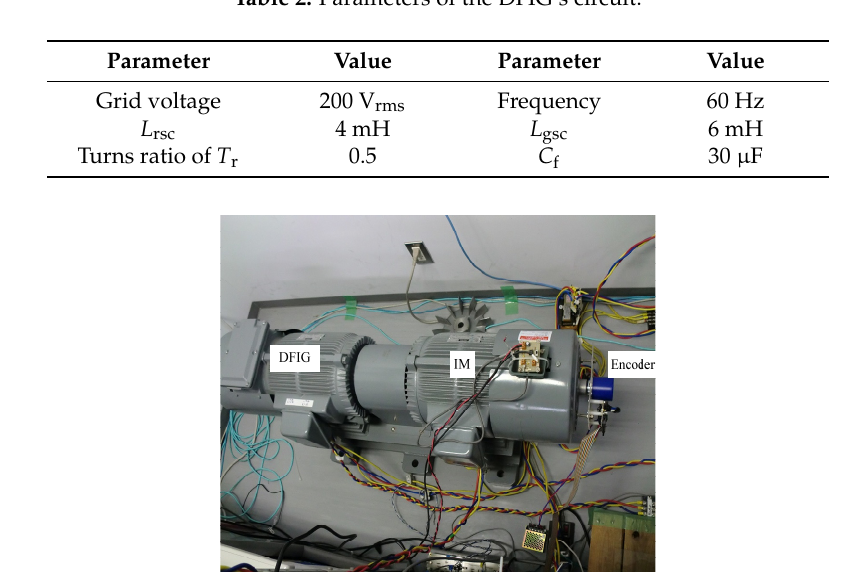
Table 2. Parameters of the DFIG’s circuit.